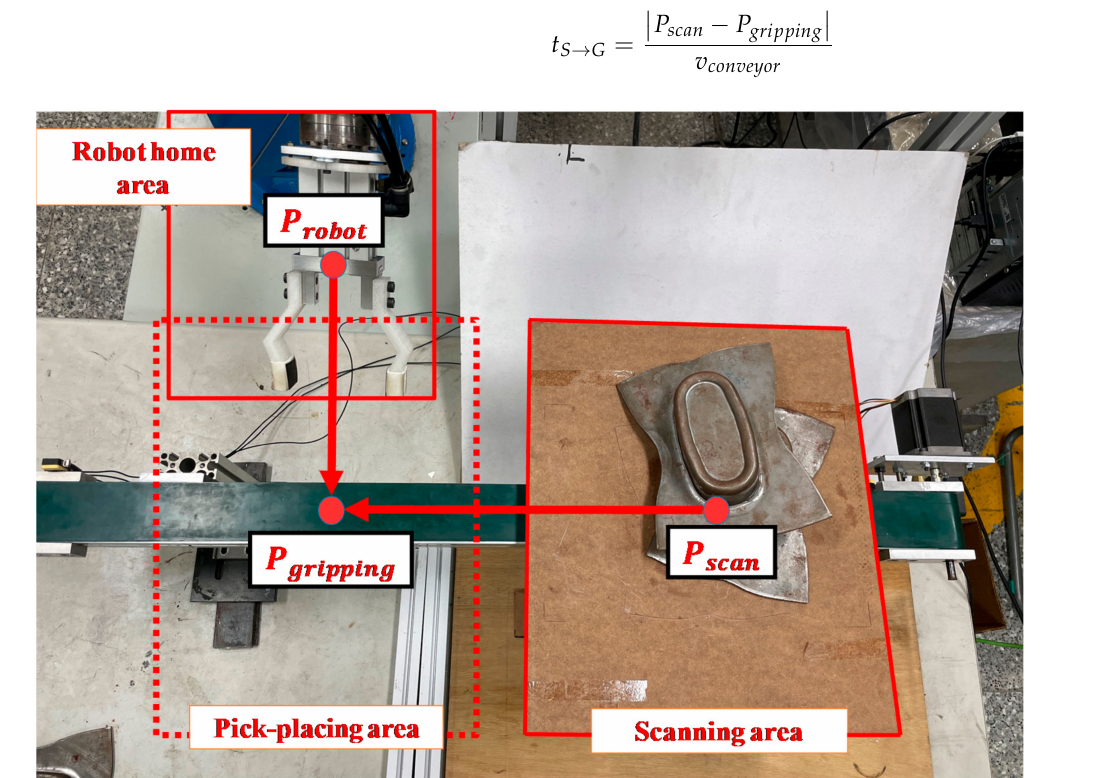
Figure 7. Initial positions of dynamic scanning region and robot gripping system on the